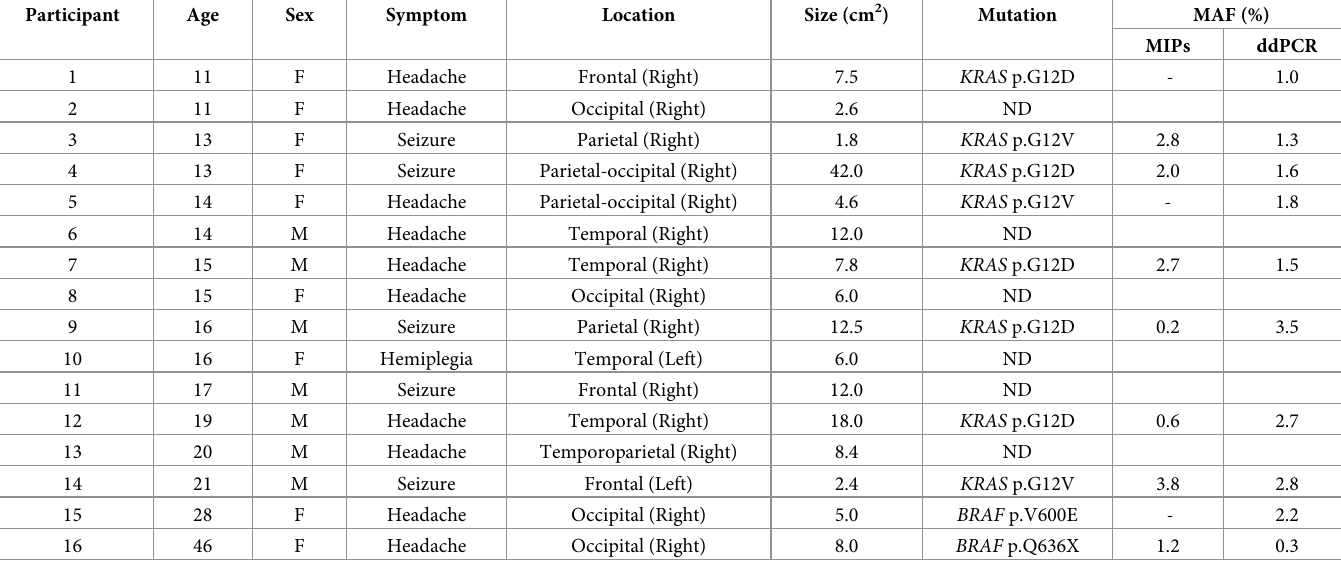
Table 1. Intracranial arteriovenous malformation (AVM) specimens and genetic